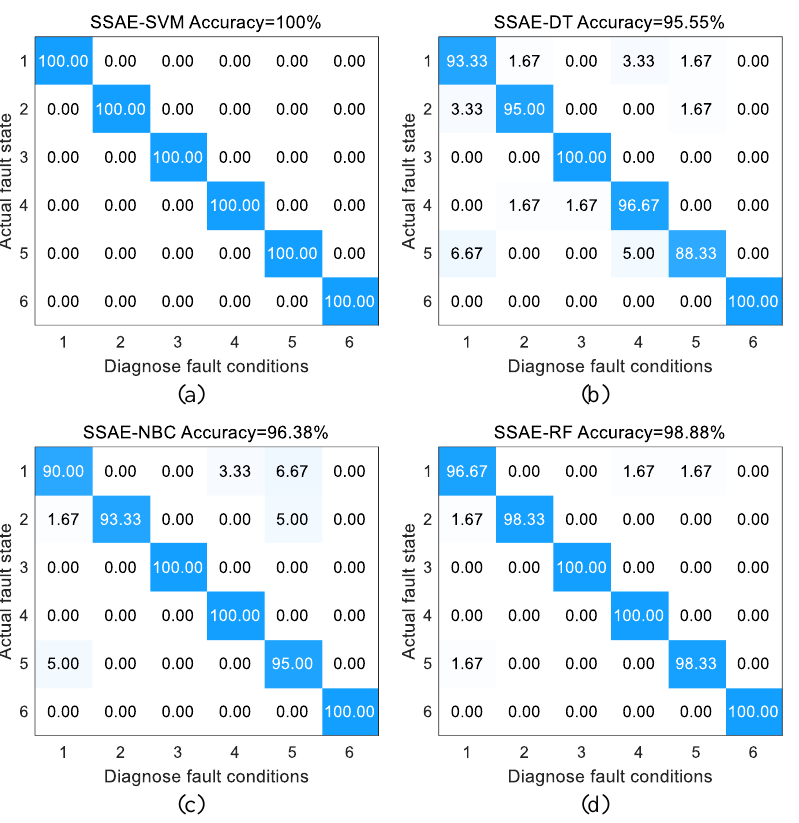
Figure 12. The diagnosis results of the different classification methods: ( a ) SVM = 100.0%; ( b ) DT = 95.55%; ( c ) NBC = 96.38%; ( d ) RF = 98.88%.